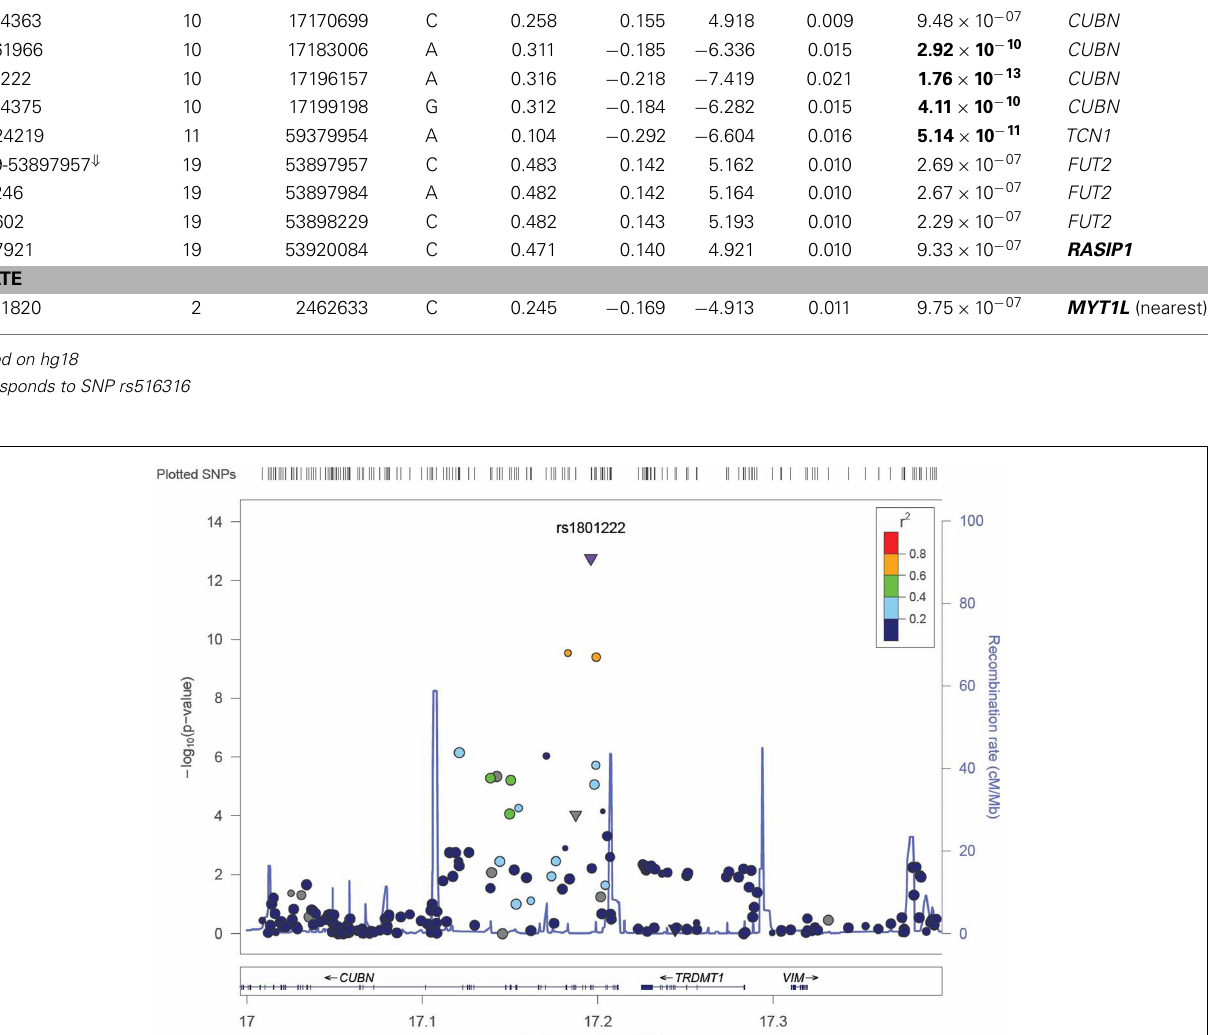
previously reported SNP associations. The most convincing asso- ciations were observed for measures of Vitamin B12 at the CUBN and TCN1 loci and the ALPL locus for measures of Vitamin